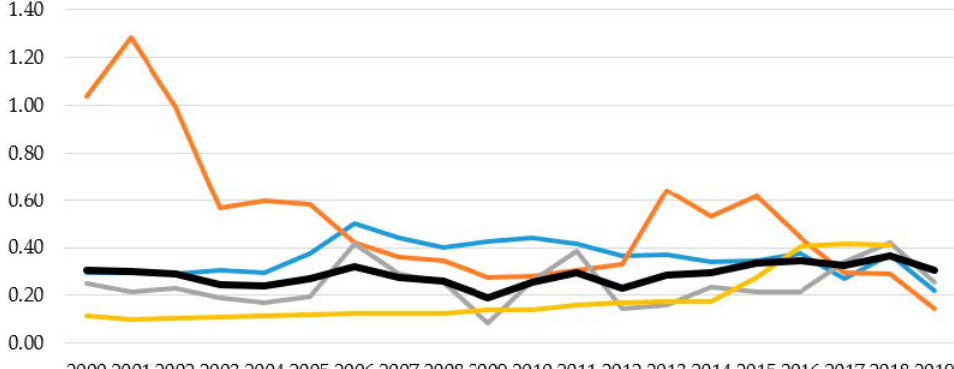
Figure 17. Dynamics of the structural components of the index of economic security for the U.S.A.: blue line–social security index, orange–industrial and service security index, grey–financial and macroeconomic security index, yellow–resource index, and black–economic security index.